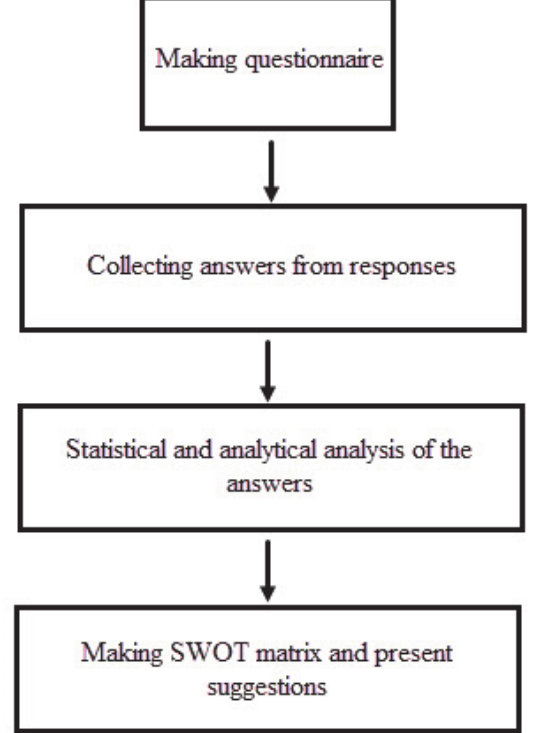
Fig. 2. The schematic of the research program